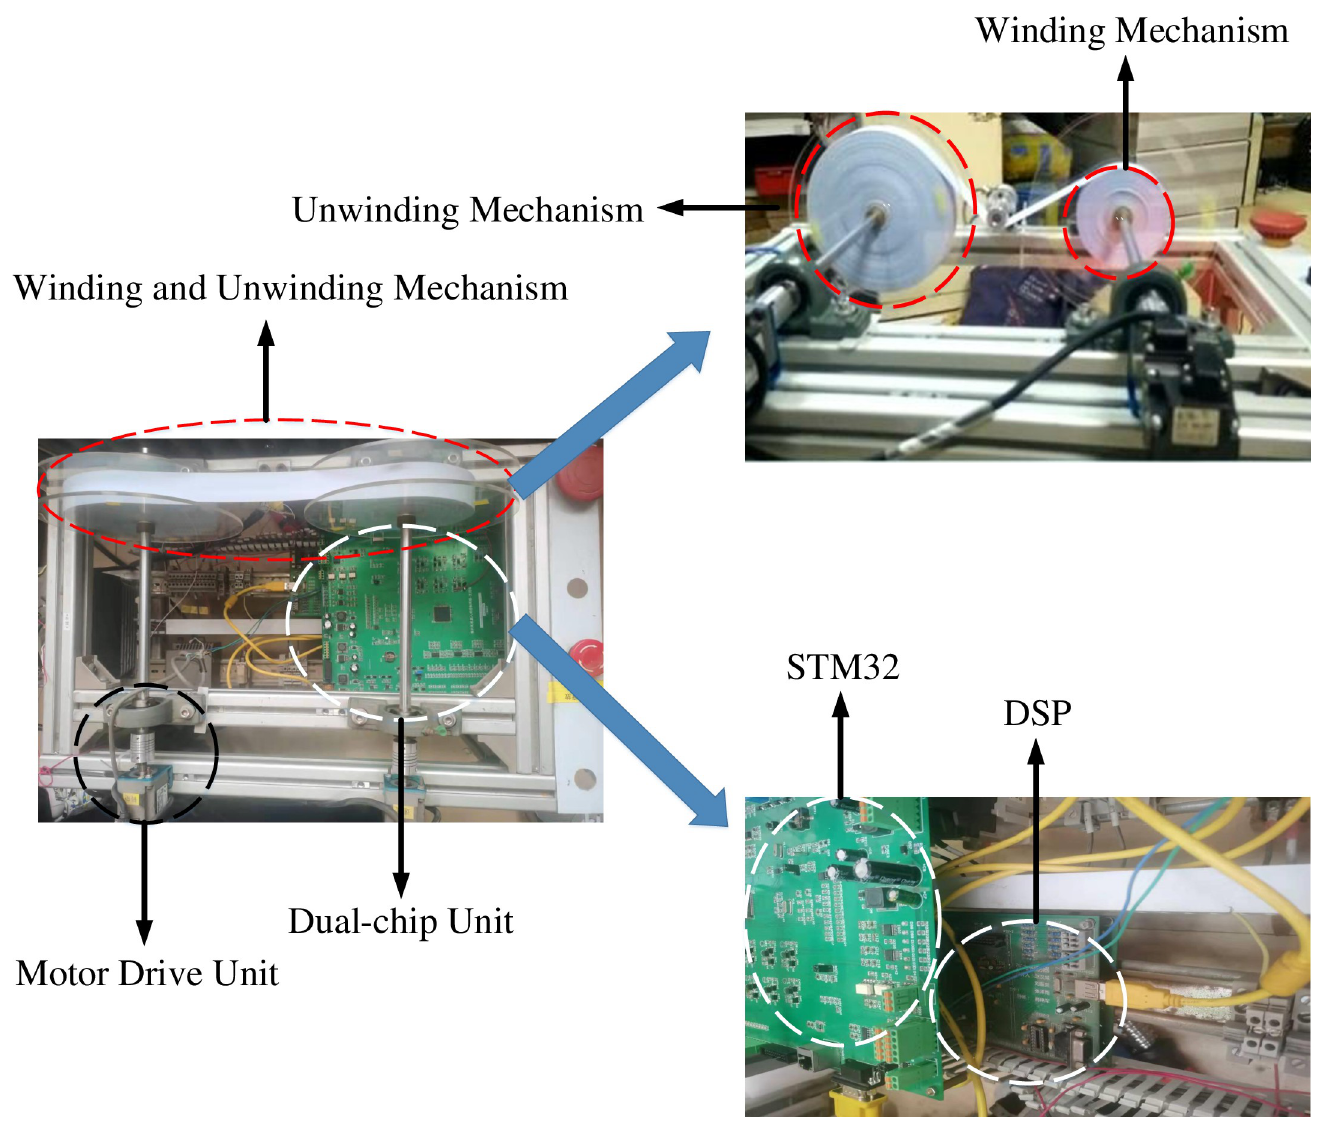
Fig 22. Tension control testing